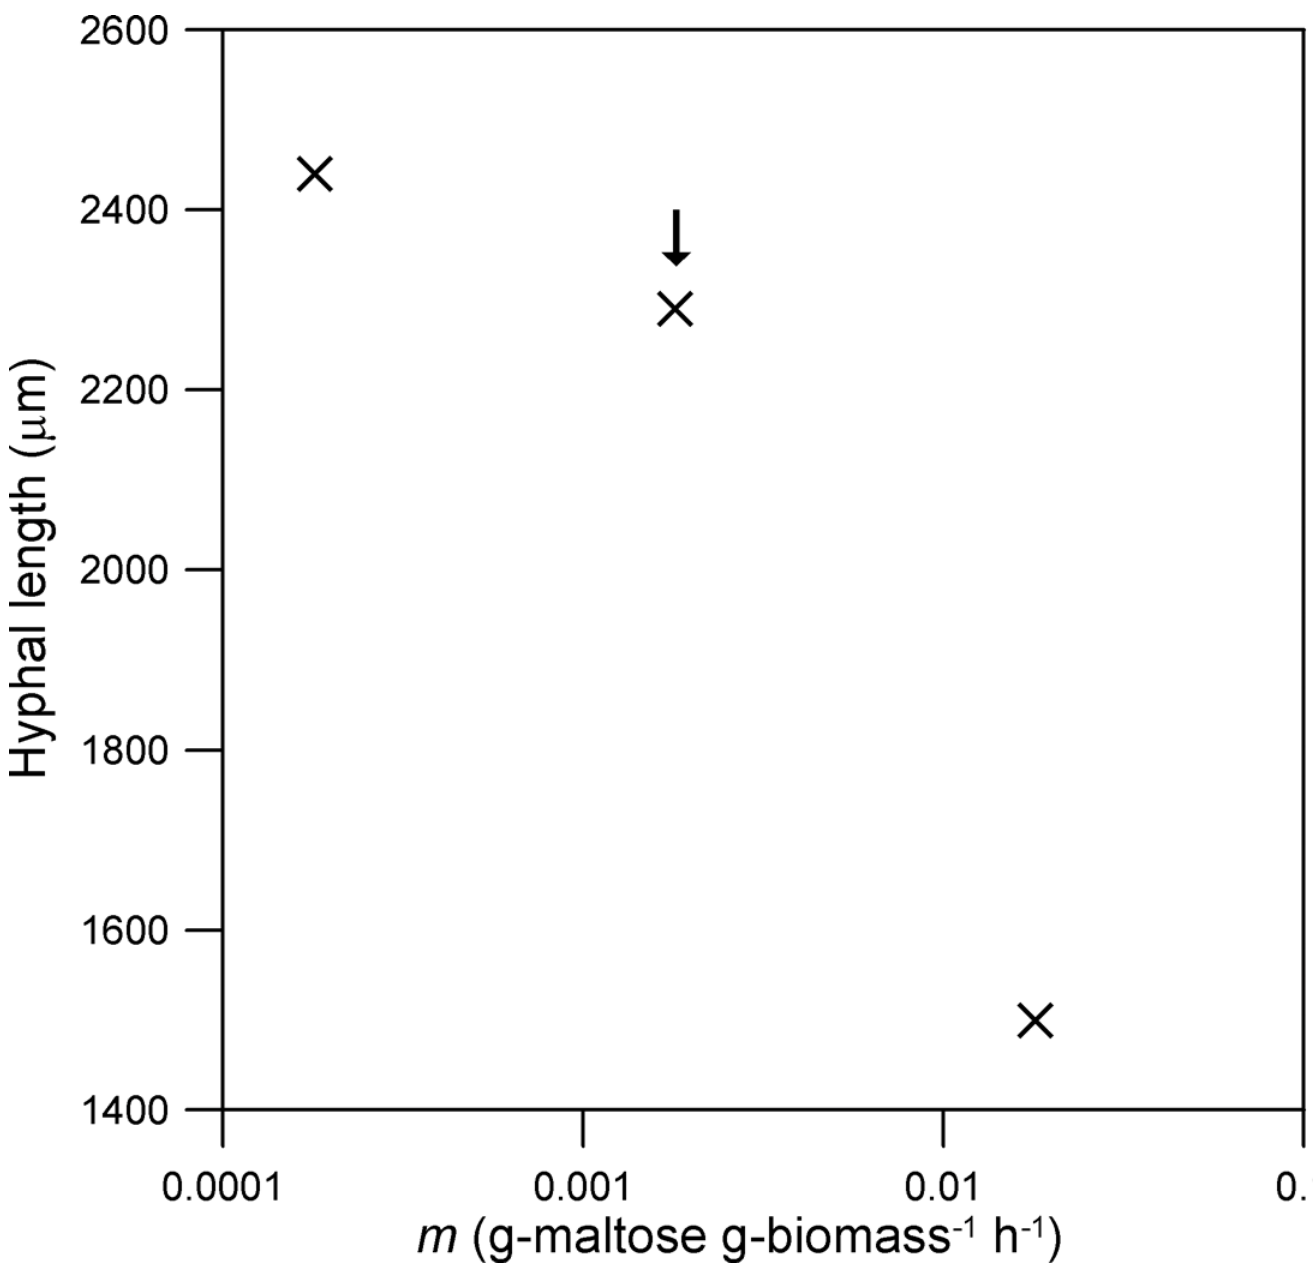
Fig 7. Effect of the maintenance coefficient ( m ). The comparison is based on the hyphal length reached at 24 h. The original value (i.e. that used for Figs. 3A and 4) is indicated with an arrow. The initial values of the variables and the other parameter values are as listed for Rhizopus oligosporus in Table